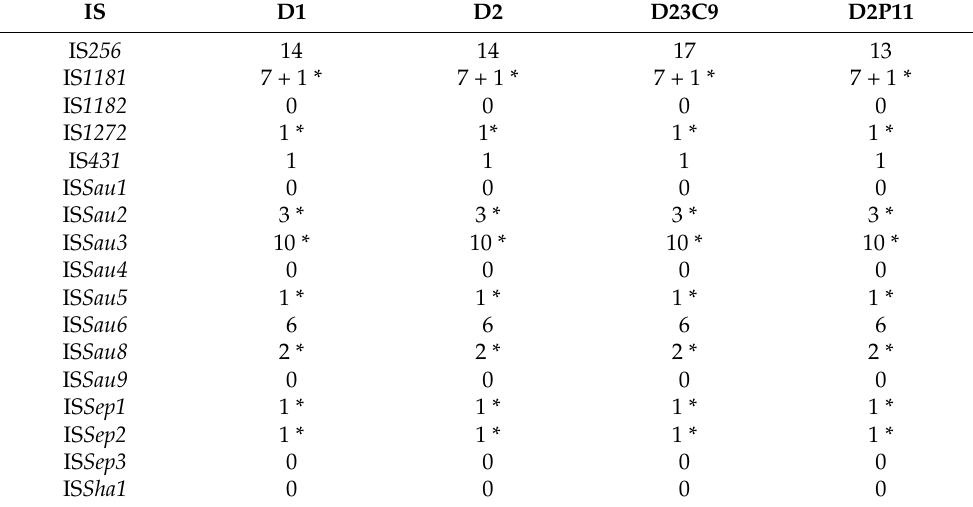
IS Sha1 0 0 * Partial IS sequence inside a Contig, >97%